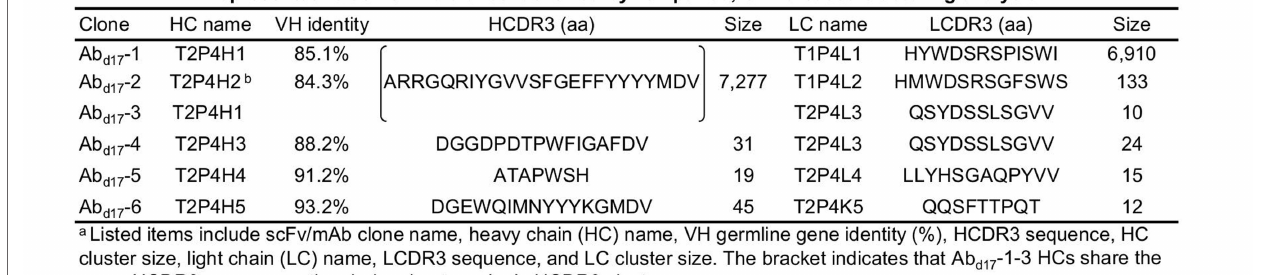
FigUre 3 | Digital panning of a diverse donor-17 single-chain variable fragment (scFv) library against the native-like trimer. A diverse scFv library was constructed from donor-17 peripheral blood mononuclear cells (PBMCs) using a complete set of primers. (a) Distributions of germline gene usage (left), somatic hypermutation (middle), and CDR3 loop length (right) are plotted for the five scFv libraries obtained from the trimer panning process. Distributions of prevalent germline gene families within IgHV4 and IgLV3 ( > 1%) are shown as insert images. Histograms are color-coded following the same scheme as in Figure 2B . (B) Identity-divergence analysis of the five donor-17 scFv libraries obtained from the trimer panning process. For each library, sequences are plotted as a function of sequence identity to PGT124 HC (top), PGT124 LC (middle), and PGT133 LC (bottom), and sequence divergence from germline genes. Color-coding indicates sequence density at a particular point on the 2D plot. Wild-type (WT) PGT124 and PGT133 are labeled on the 2D plots as black dots. Sequences with CDR3 identity of 95% or greater are shown as orange dots, with the number of sequences and library percentage labeled on the 2D plot for comparison. (c) Representative scFv clones identified from a diverse scFv library by H/L-paired, CDR3-based clustering analysis for mAb